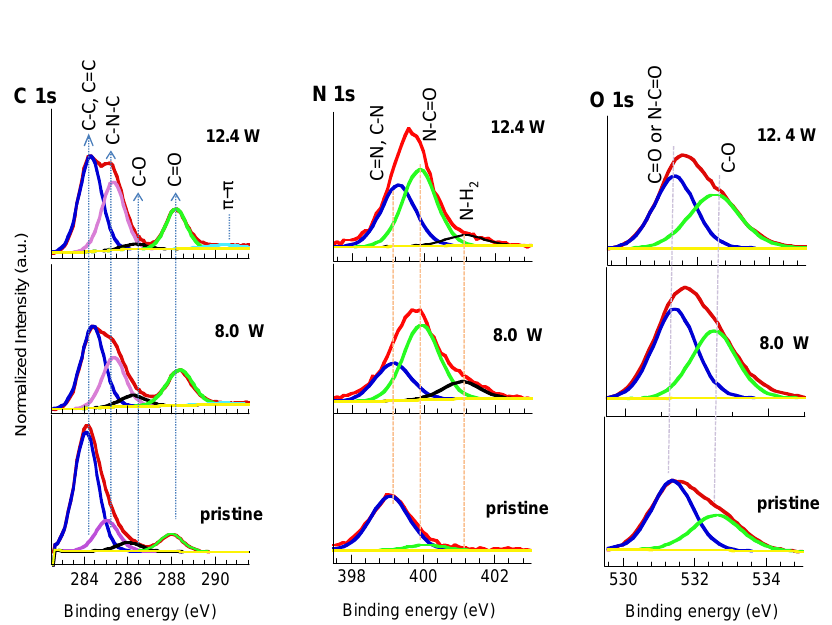
Figure 7. High resolution C 1s, N 1s and O 1s spectra of polyimide before and after He-H 2 O plasma treatment, at various discharge power, a fixed gas flow rate and treatment time of 30